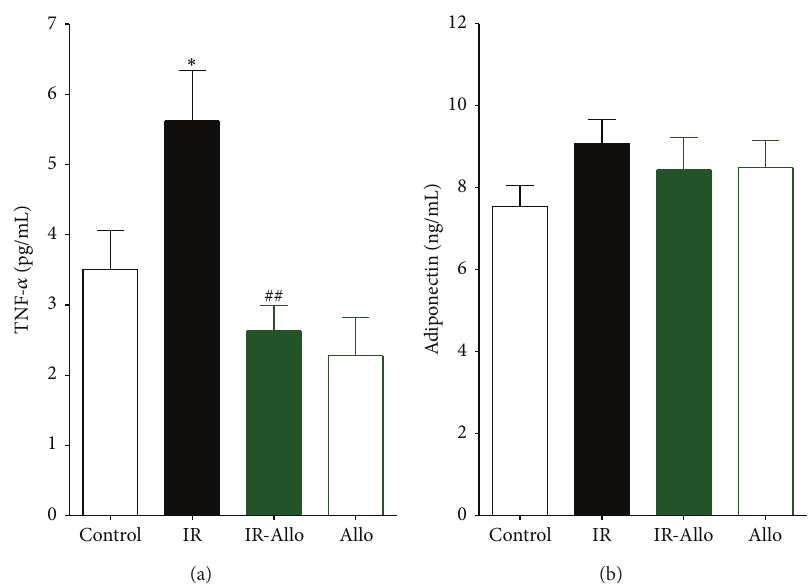
Figure 4: The effect of allopurinol (Allo) treatment on insulin resistance (IR) induced TNF- 𝛼 (a) and adiponectin (b), where they are measured in pg/mL. Values are expressed as the mean ± SEM; 𝑁 = 6 – 8 animals; ∗ 𝑃 < 0.05 , ∗∗ 𝑃 < 0.01 , and ∗∗∗ 𝑃 < 0.001 , compared with the corresponding control group values; # 𝑃 < 0.05 and ## 𝑃 < 0.01 compared with the corresponding IR group values, by One-Way ANOVA and Newman-Keuls post hoc test.